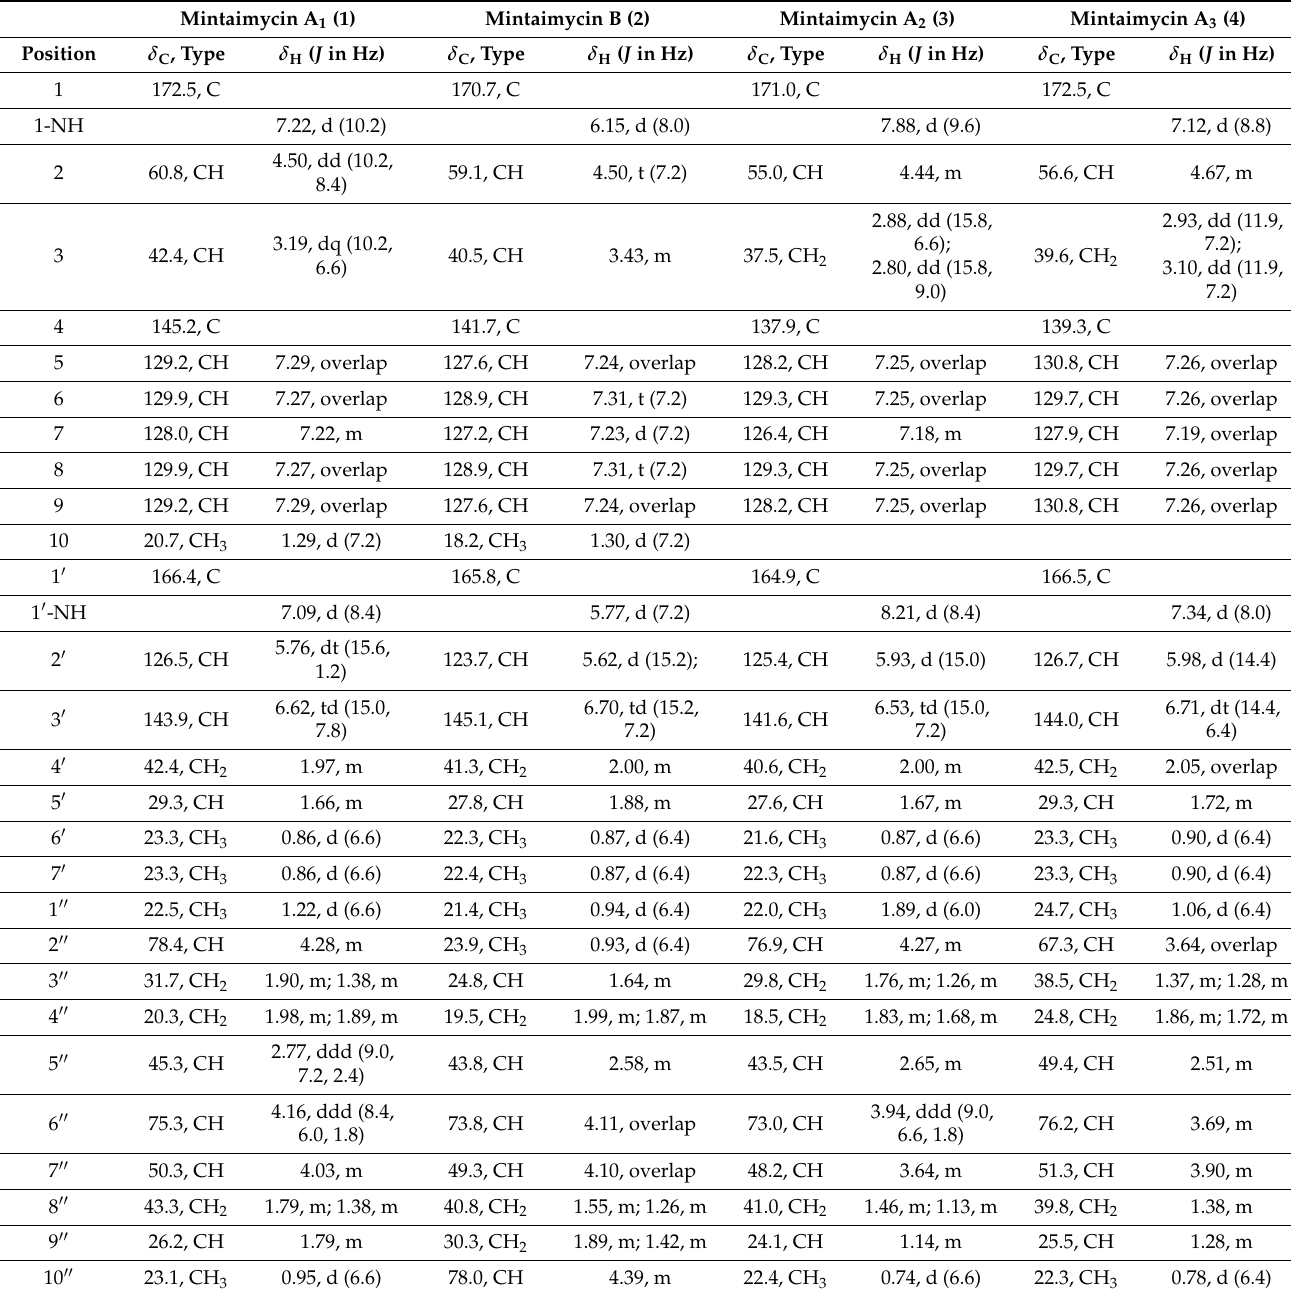
Table 1. NMR data of mintaimycins A 1 ( 1 ), B ( 2 ), A 2 ( 3 ) and A 3 ( 4